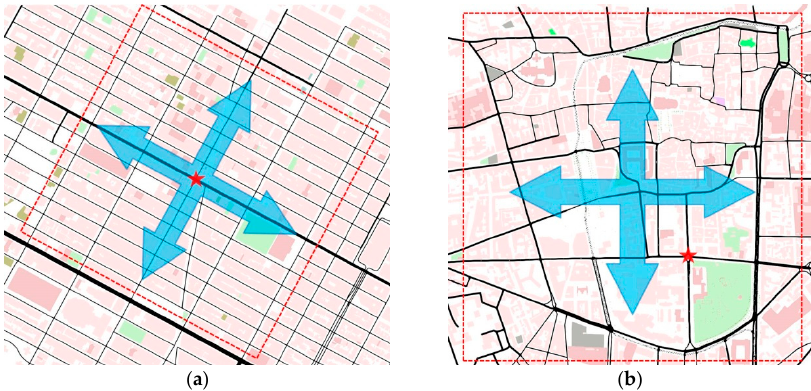
Figure 6. Urban Maps: ( a ) Manhattan Island in New York City (USA); ( b ) Clermont-Ferrand (France); Traffic routes are indicated by arrows in urban scenarios; The red start is the source node that periodically broadcasts data messages; The red broken line indicates the boundary of ROI. Table 2. Statistics of maps.